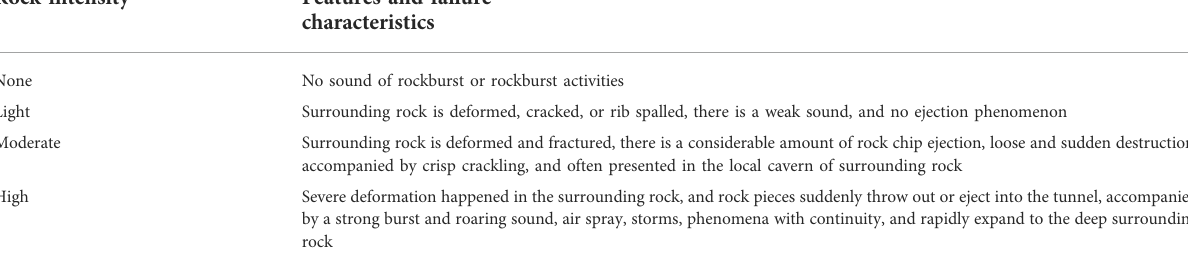
TABLE 1 Classi fi cation criterion for rockburst intensity proposed by Zhou et al. (2012). Rock intensity